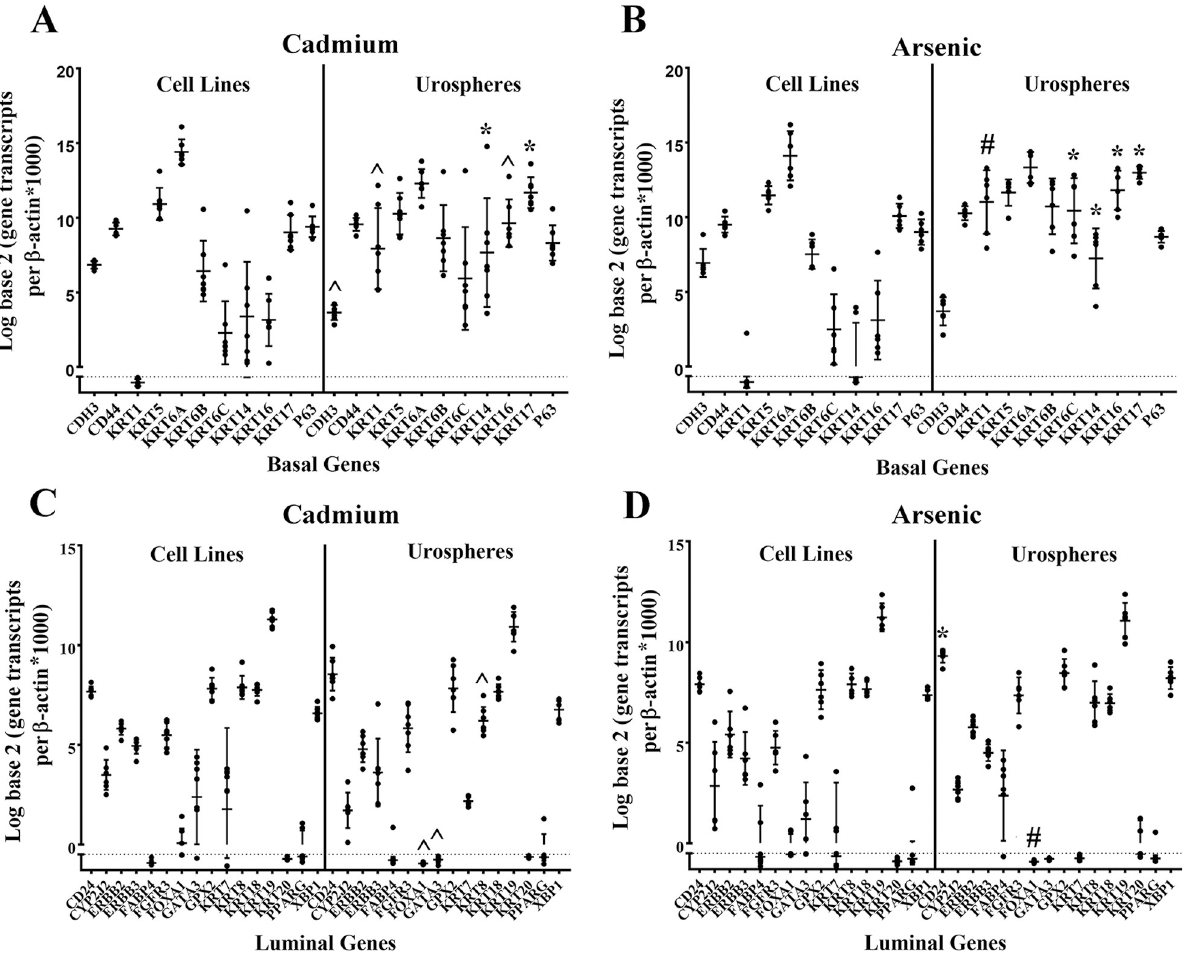
Fig 7. Gene expression analysis of basal and luminal marker genes in the As 3+ and Cd 2+ -transformed cell lines and their corresponding urospheres. (A and B). Real-time PCR analysis of basal marker genes in Cd 2+ (A) and As 3+ (B) transformed cell lines and urospheres. (C and D). Real-time PCR analysis of luminal marker genes in Cd 2+ (C) and As 3+ (D)-transformed cell lines and urospheres. Analysis was done in triplicates and is plotted as the mean ± SD. The data is plotted on a log base 2 scale per transcript of β -actin times 1000. � indicates significantly different at p < 0.05 from transformed UROtsa cells. # indicates significantly different at p < 0.01 from transformed UROtsa cells. ^ indicates significantly different at p < 0.001 from transformed UROtsa